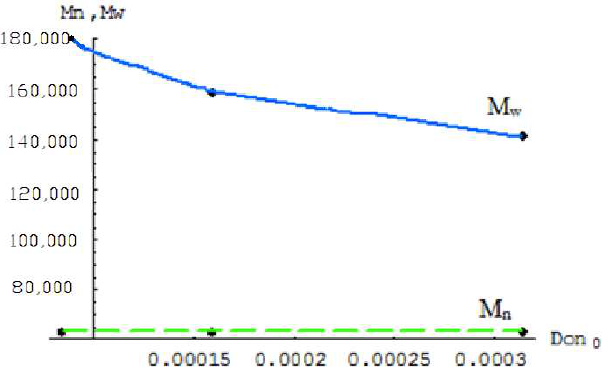
Figure 3. Dependence of the polydispersity coefficient of the Kwn (cid:2914)(cid:2911)(cid:2930) fraction of diblock polypro- pylene chains starting their growth on the 2nd type of AC on the residence time in the reactor (cal- culated with the basic values of the model parameters).